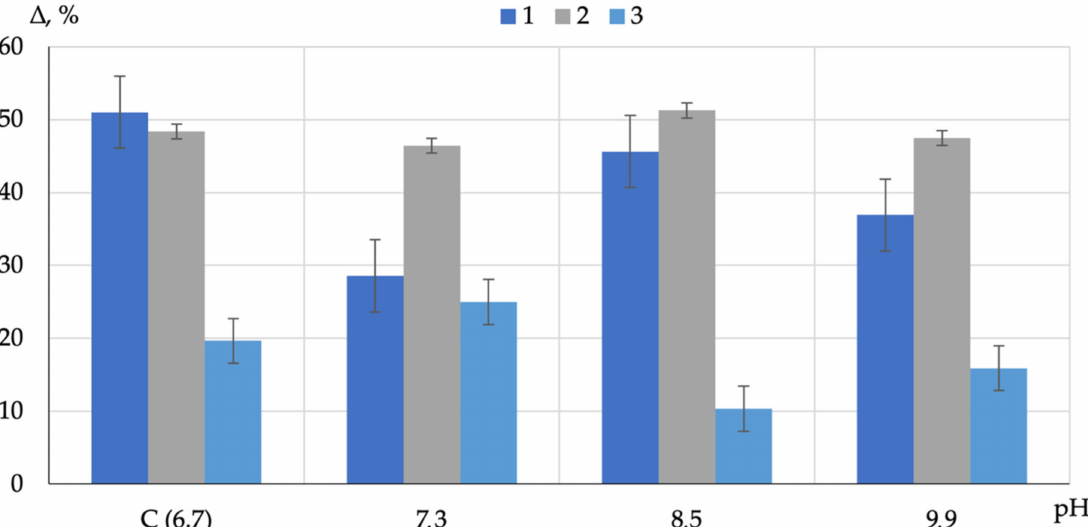
Figure 6. Dependence of the difference between the strength characteristics of layers of variatropic sections of vibro- centrifuged concrete on the pH level of activated water (1—the difference between the inner and middle layer; 2—the difference between the inner and outer; 3—the difference between the middle and outer; C is the control composition; ∆ is the value of the change in the coefficients of the strength variatropic efficiency).